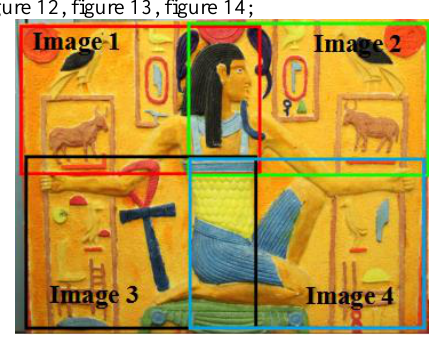
Figure 12. One to one correspondence between local image and whole